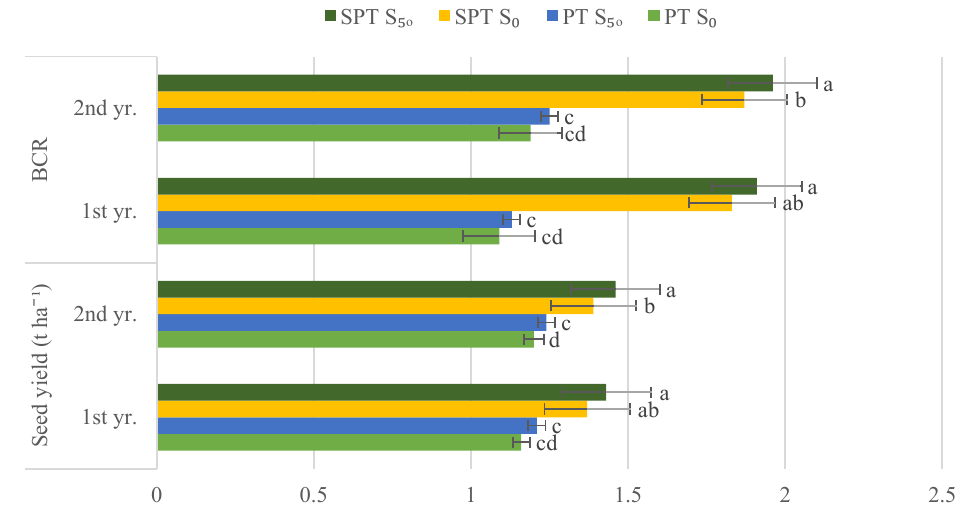
Figure 1. Effect of tillage method and rice stubbles on rapeseed yield (t ha -1 ) and BCR during